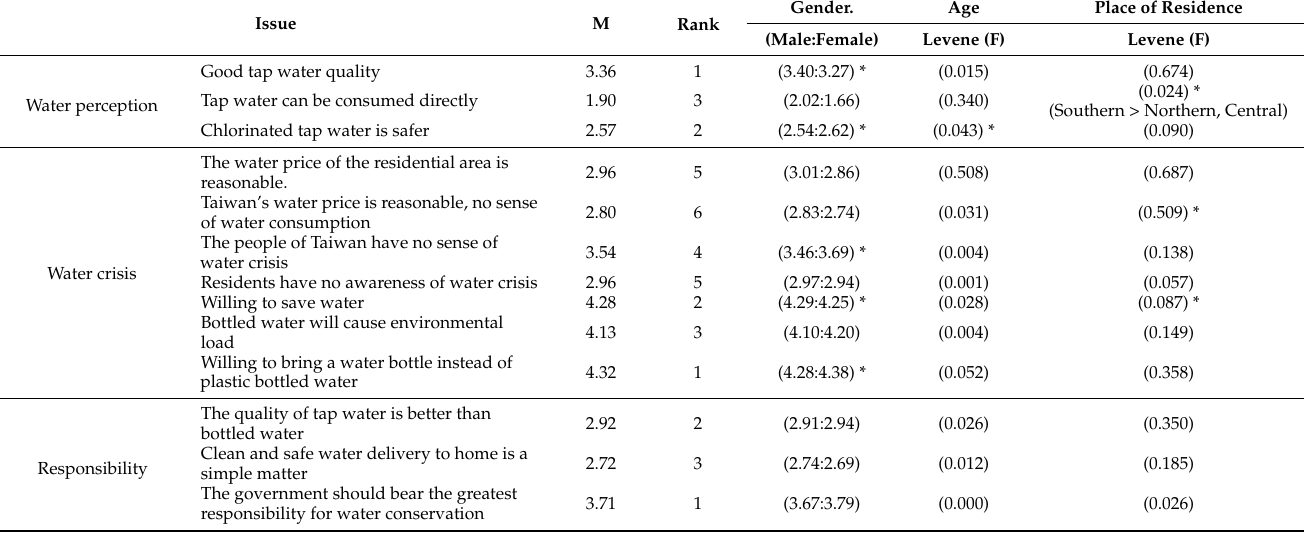
Table 3. Water use attitude analysis of the Taiwanese